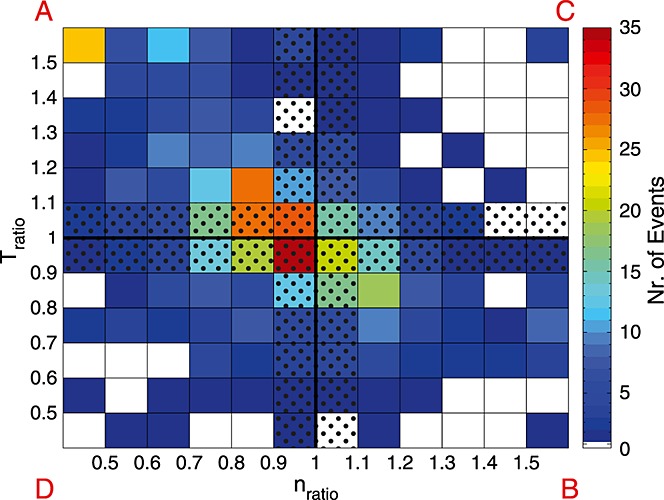
Scattered plot of the ion Tratio and nratio divided into 10% bins. The dotted area mark the events which are NOT considered for the statistical analysis.